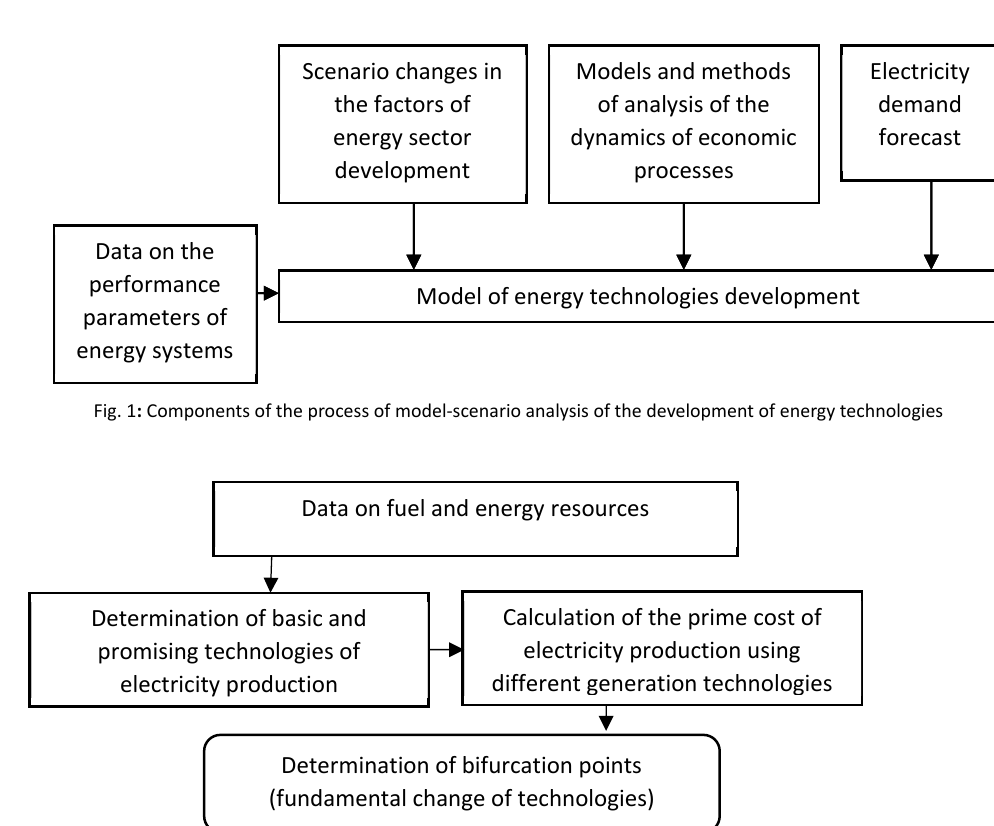
Fig. 2: Model for determination of the future dominant technologies of electricity production